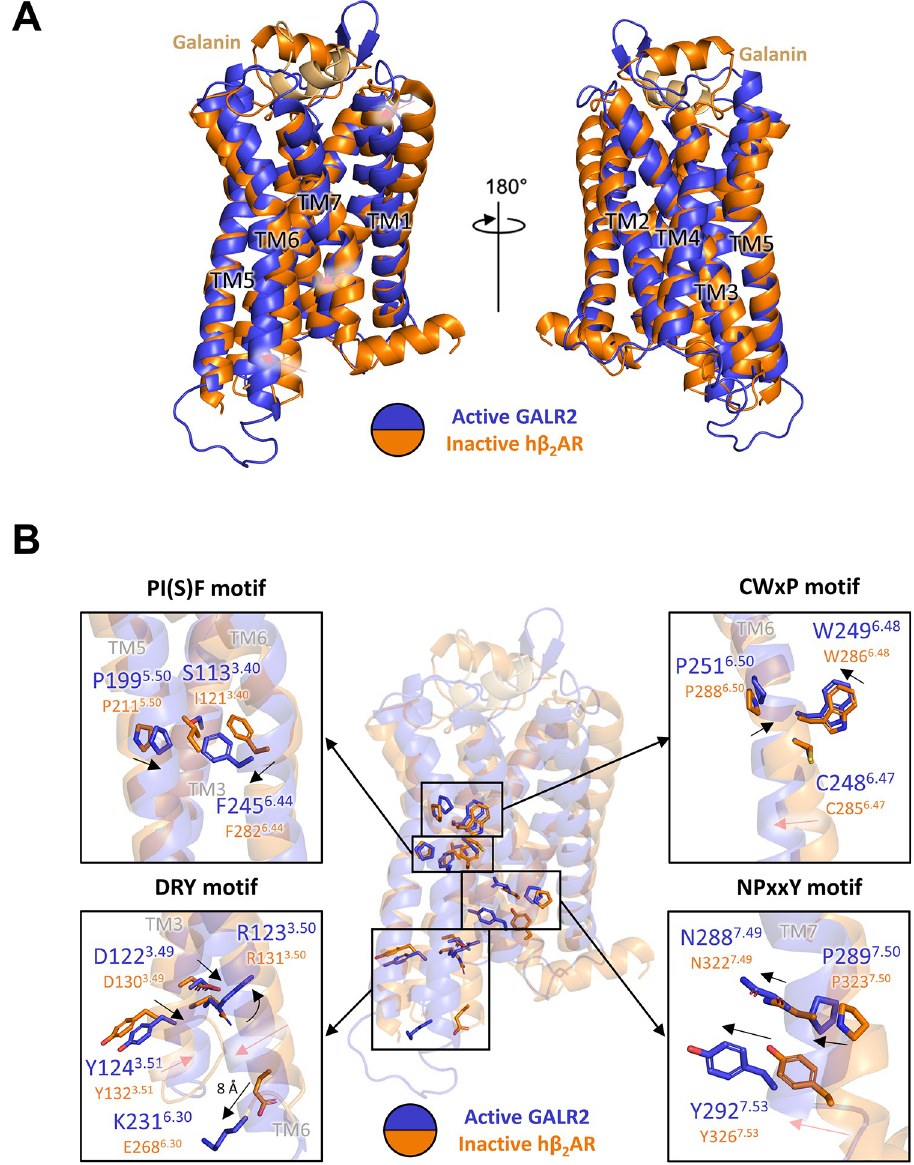
Fig 4. Comparison of the conserved motifs between active GALR2 and inactive h β 2 AR. (A) The overall structures of activated GALR2 and inactive h β 2 AR in 2 different orientations. GALR2, h β 2 AR, and galanin are shown as a ribbon diagram. Active GALR2, inactive h β 2 AR, and galanin are colored in blue, orange, and light orange, respectively. The movements of TM1, TM6, and TM7 are indicated by red arrows. PDB code of the inactive structure of h β 2 AR is 2RH1. (B) The conserved motifs are shown as a stick model. The movements of the residues are indicated by black arrows, and the movements of TM are indicated by red arrows. TM,